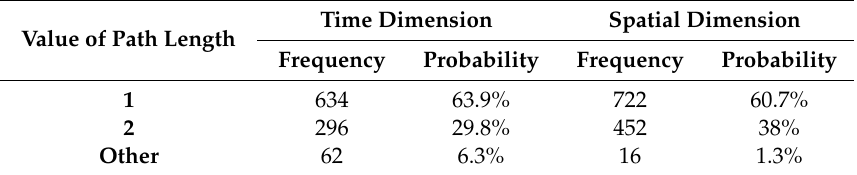
Table 3. Distance analysis of disaster network in both the time dimension and spatial